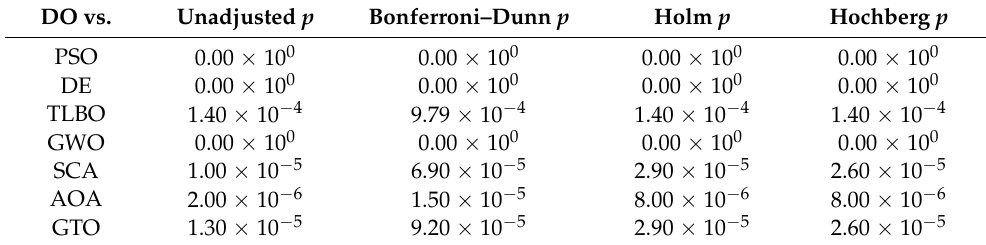
Table 10. Post hoc analyses for the multiple comparisons between DO and other nature-inspired algorithms when optimizing the delamination size at the top